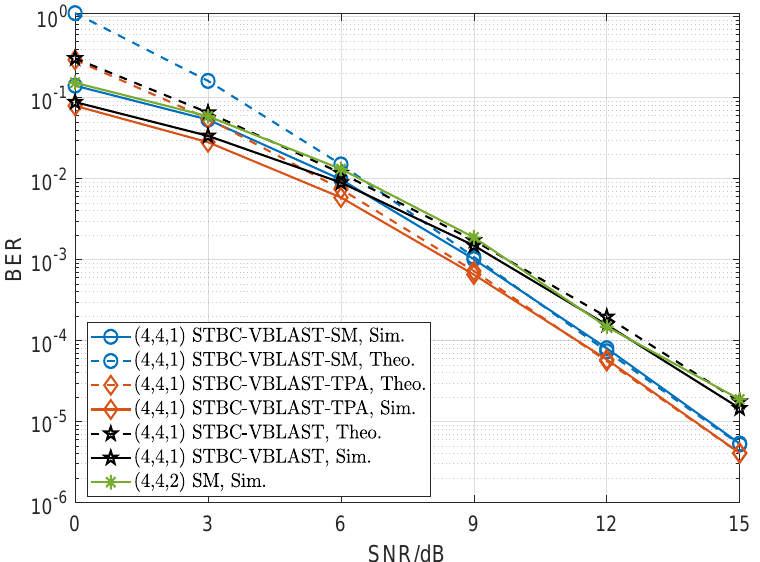
Figure 10. Performance comparisons of the ( 4,4,2 ) SM system, ( 4,4,1 ) STBC-VBLAST-SM system, STBC-VBLAST-TPA system and traditional STBC-VBLAST system, where 3 bits/s/Hz for the STBC- VBLAST-SM system and 4 bits/s/Hz for the STBC-VBLAST-TPA and STBC-VBLAST